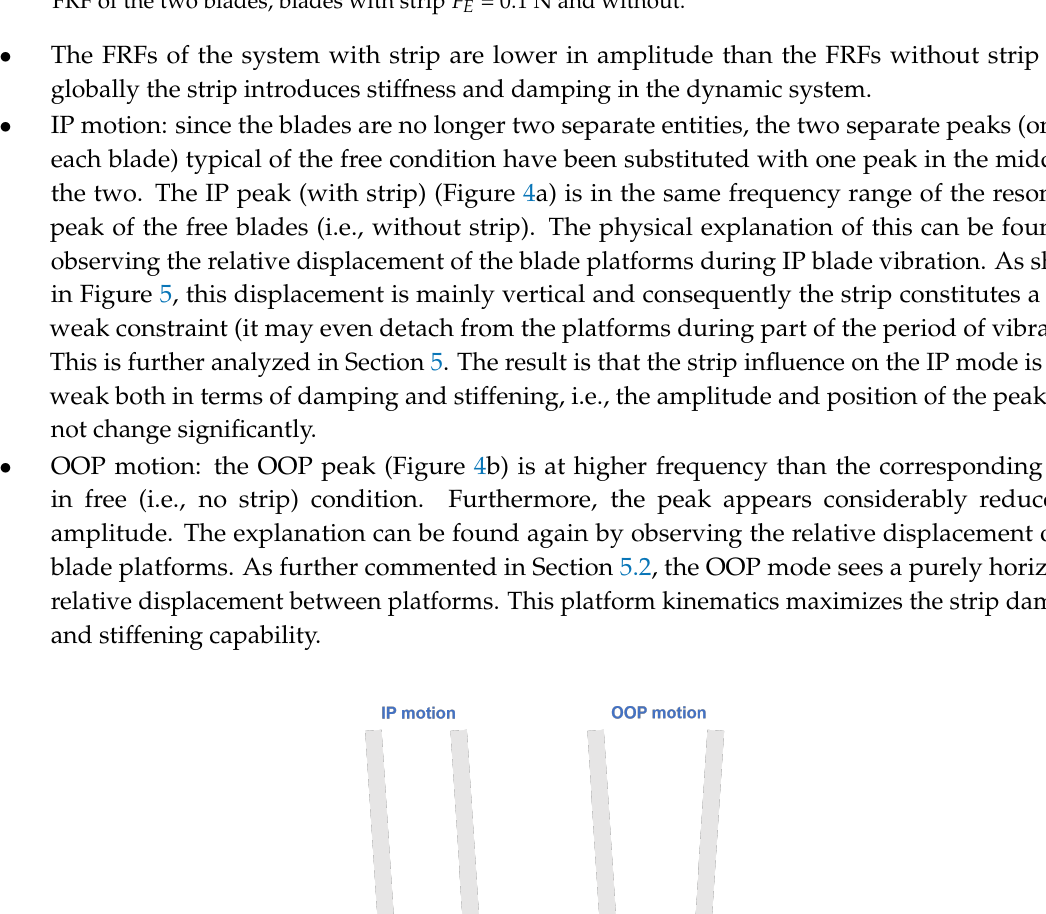
Figure 4. ( a ) IP FRF of the two blades, blades with strip F E = 0.1 N and without. ( b ) OOP (out of phase) FRF of the two blades, blades with strip F E = 0.1 N and without.